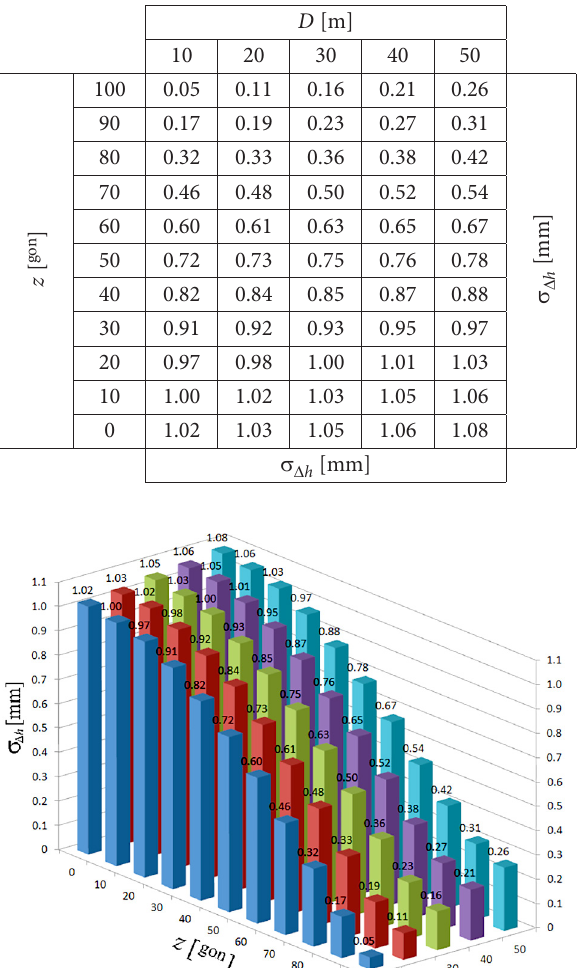
Figure 2. A general illustration of the mean error determining the height difference h D by the trigonometrical method, depending on the accuracy of determining slope distances D and zenithal distances z